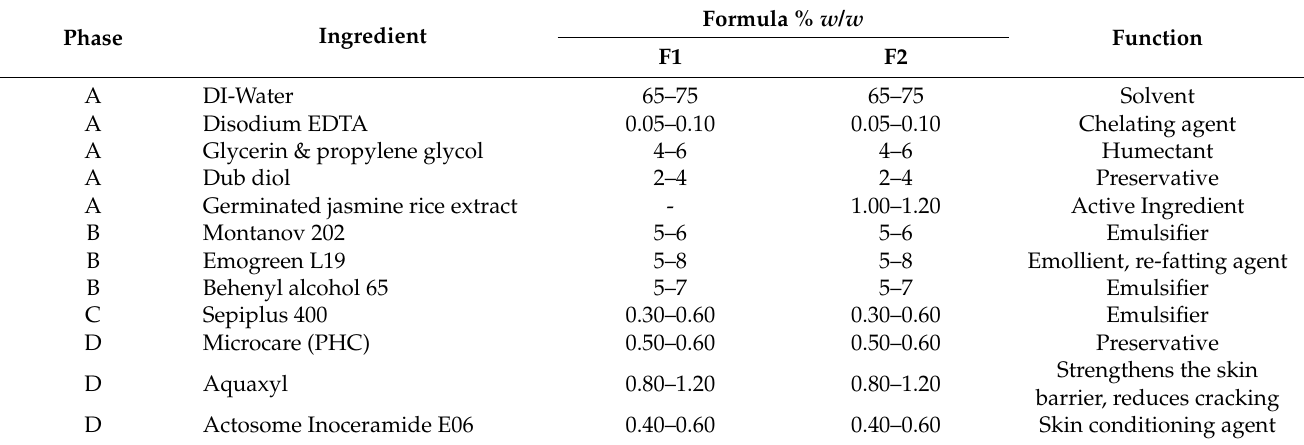
Table 1. The ingredients, percentages and function